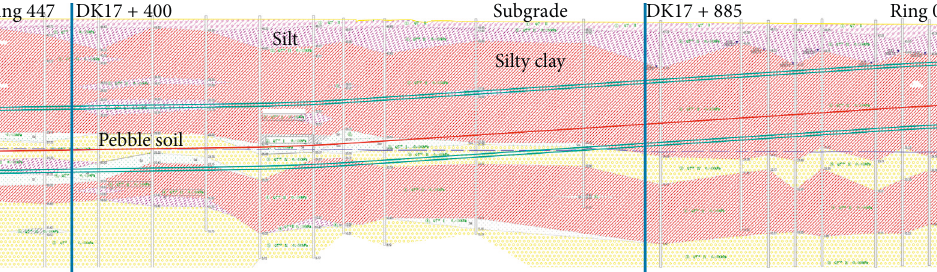
Figure 3: Geological profile of the 0–447 rings.